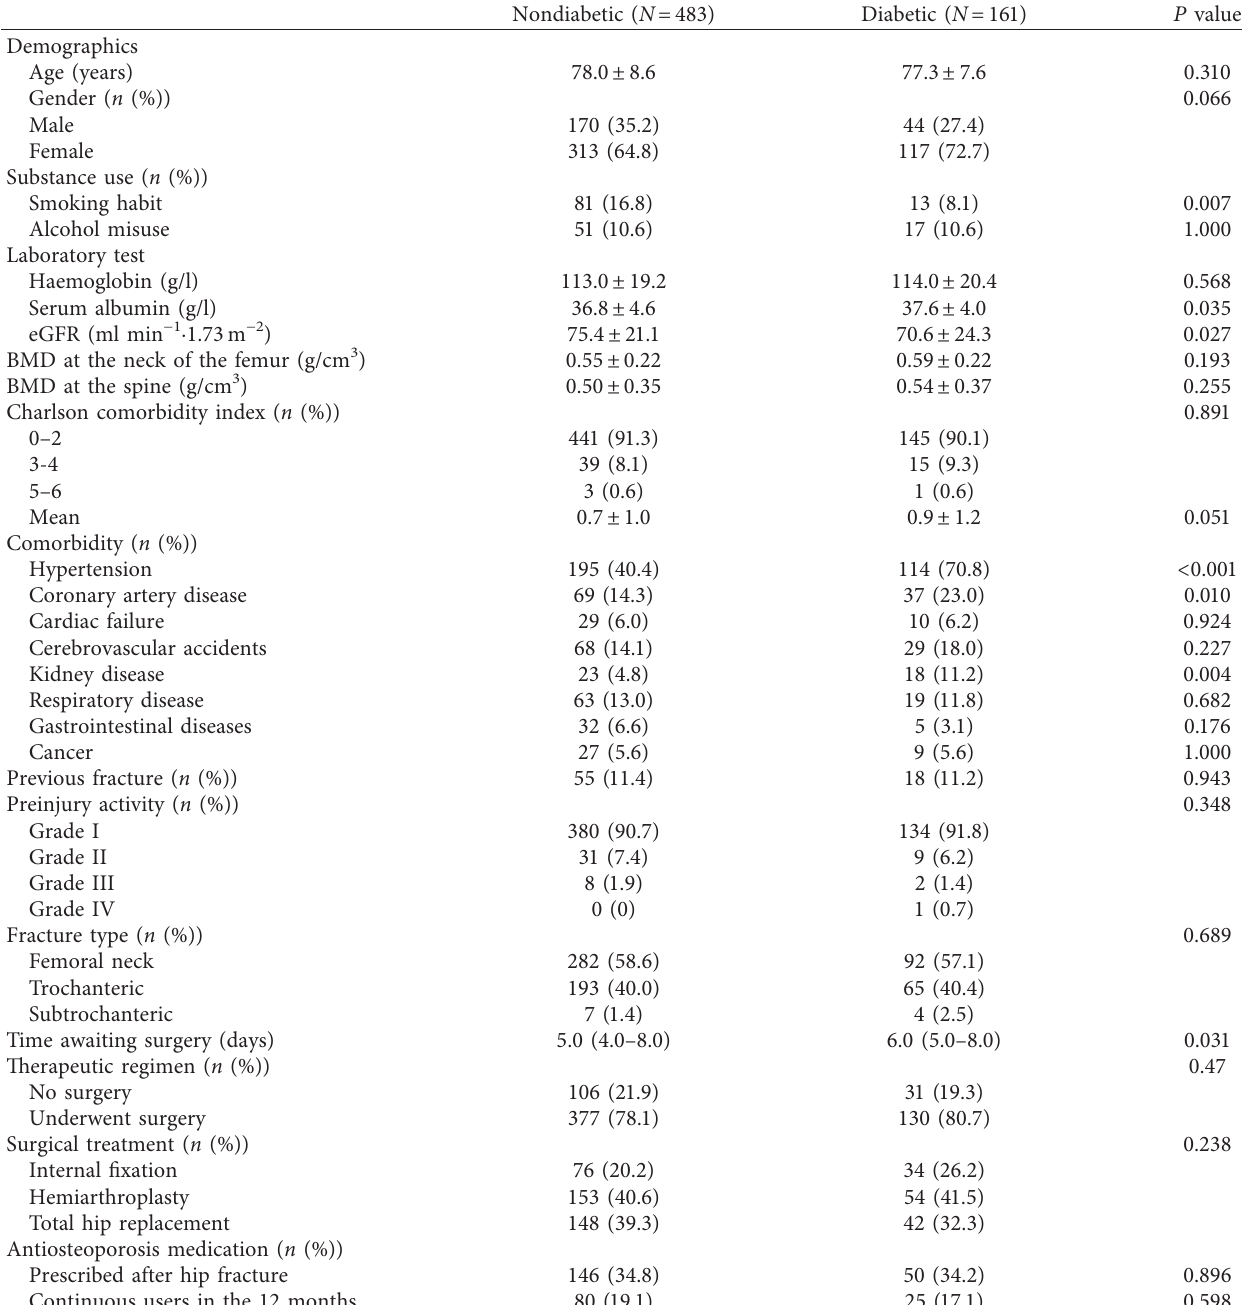
Table 1: Comparison of general characteristics of the two groups of